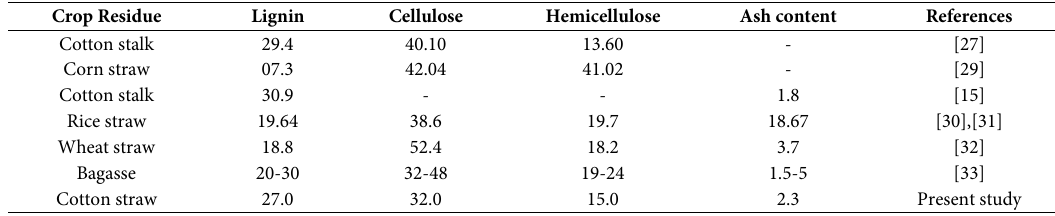
Fig. 2. Extraction of nanocellulose Table 1. Lignocellulosic biomass content in Percent